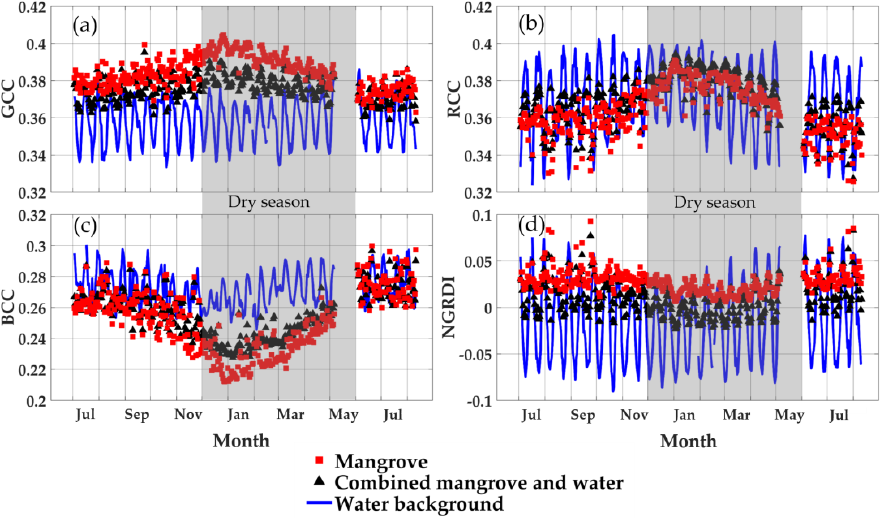
Figure 6. Phenocam-2 RGB color index seasonal profiles of the mangrove forest (ROI 1), water (ROI 4), and combined mangrove–water canopy (ROI 2) from July 2015 to August 2016: ( a ) GCC, ( b ) RCC, ( c ) BCC, and ( d ) NRGDI (blank area in May 2016 is missing data due to phenocam malfunction).